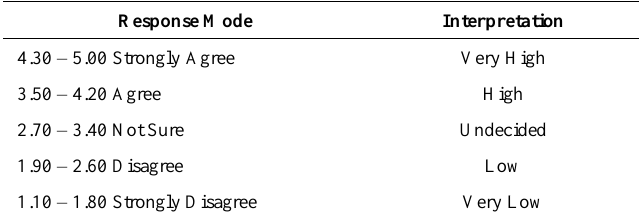
Table 2. Numerical values and response modes used to interpret the means